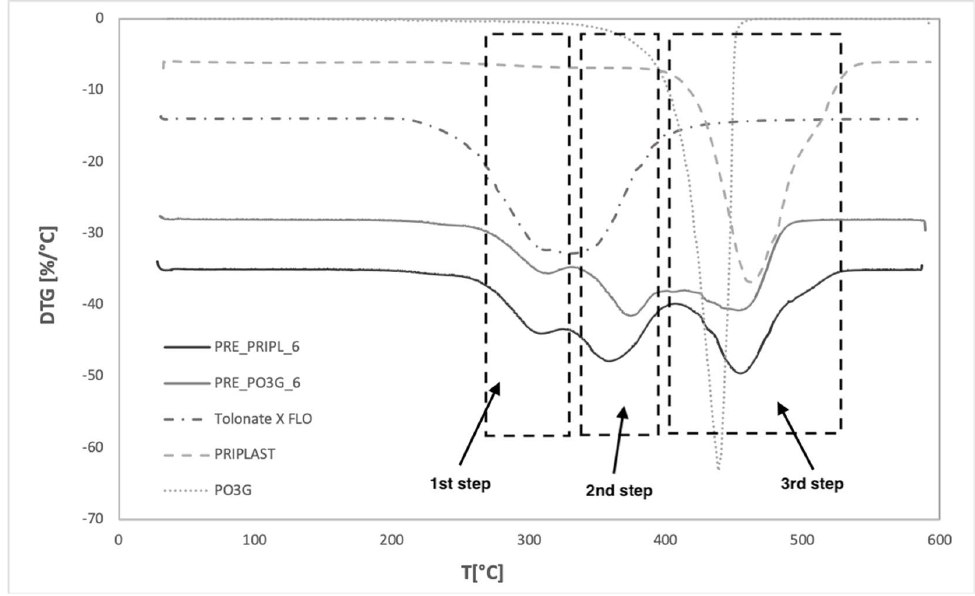
Figure 9. Dependence of DTG in the function of temperature for monomers and the obtained bio based prepolymers with NCO ca. 6%.